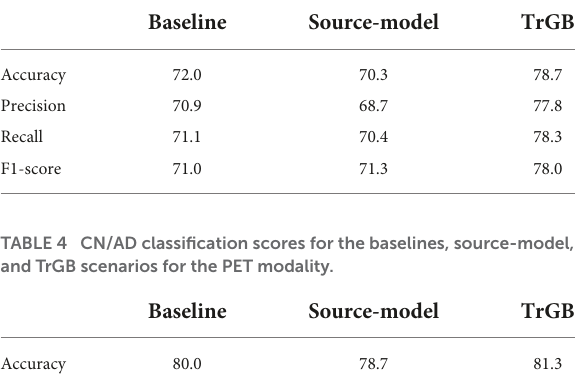
TABLE 3 CN/AD classification scores for the baseline, source-model, and TrGB scenarios for the MRI modality.